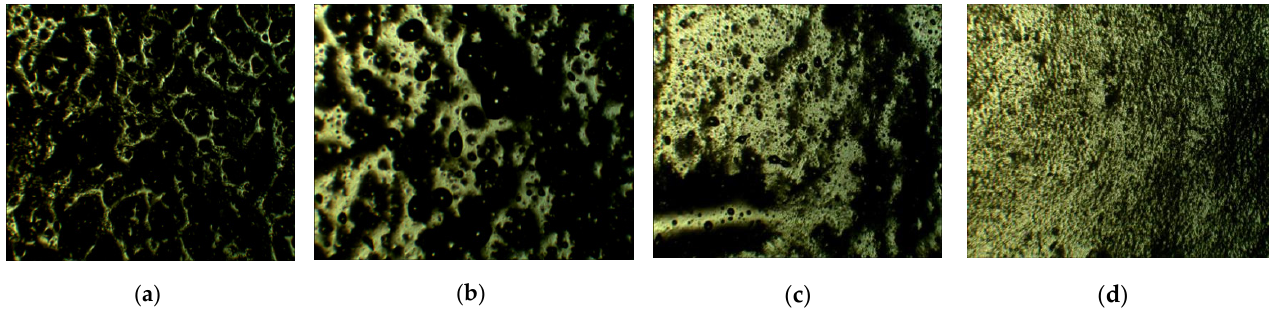
Figure 2. Morphology of the multi-walled carbon nanotubes-liquid crystal-polydimethylsiloxane (MWCNT-LC-PDMS) composite with concentrations of LC in PDMS of ( a ) 0 wt%; ( b ) 20 wt%; ( c ) 40 wt%; and ( d ) 60 wt%.